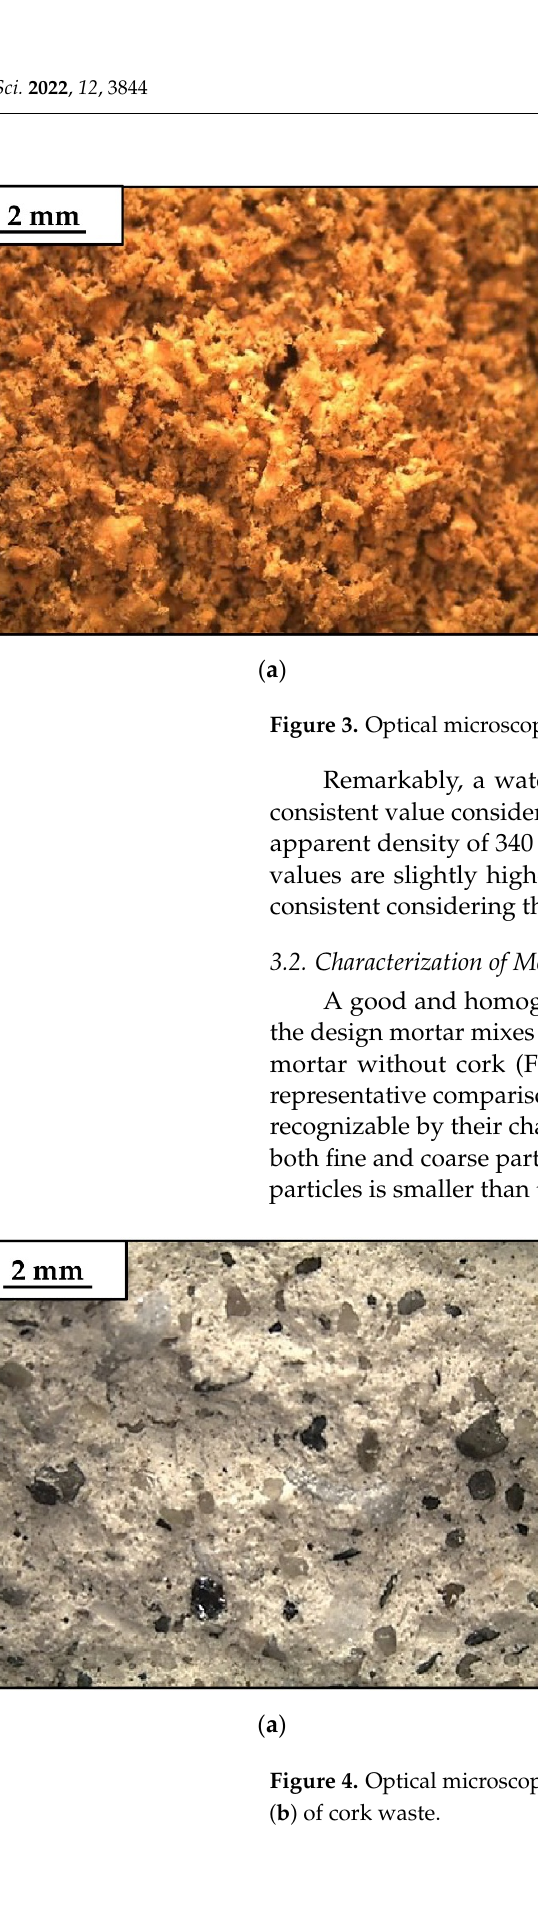
( b ) Figure 5. Color variation of mortar samples induced by the addition of cork waste: visual macro- scopic evidence of mortars containing increasing cork content from left to right ( a ) and colorimetry values of representative samples containing 0 wt% and 4 wt% of cork ( b ).